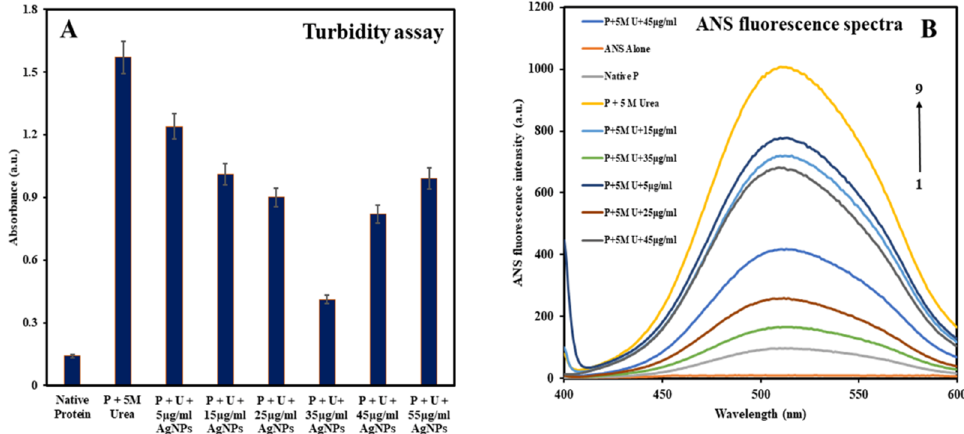
Figure 2. ( A ) Turbidity assay of native HSA, HSA containing 5 M urea, and HSA containing 5 M urea in the presence of increasing quantities of B-AgNPs. Each experiment was repeated three times. The final protein concentration was 5 µM, and the turbidity was determined at 360 nm. ( B ) ANS fluorescence spectra of native HSA, HSA incubated with 5 M urea, and HSA incubated with increasing concentrations of B-AgNPs in addition to the fixed concentration of 5 M urea. The excitation wavelength was 380 nm, and the emission wavelength was between 400 and 600 nm. The width of the excitation slit was set to 10 nm, while the width of the emission slit was set to 5 nm.